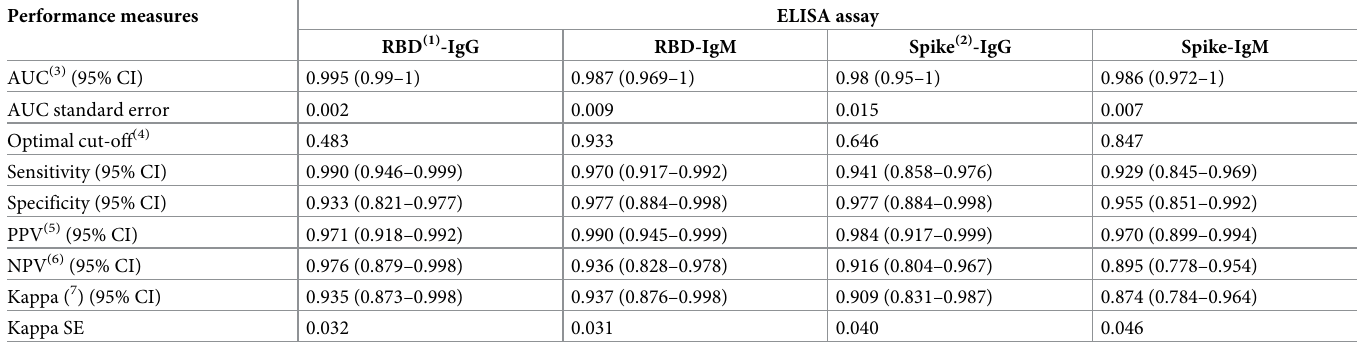
Table 2. Performance of ELISA tests as estimated by ROC